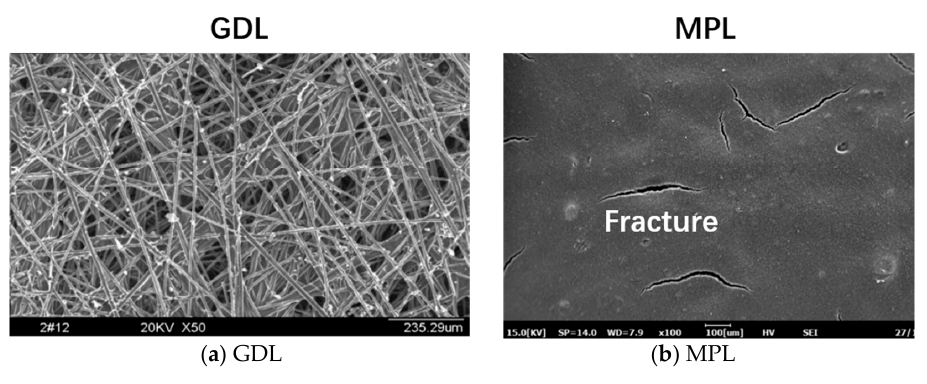
Figure 1. SEM image of GDL and MPL.